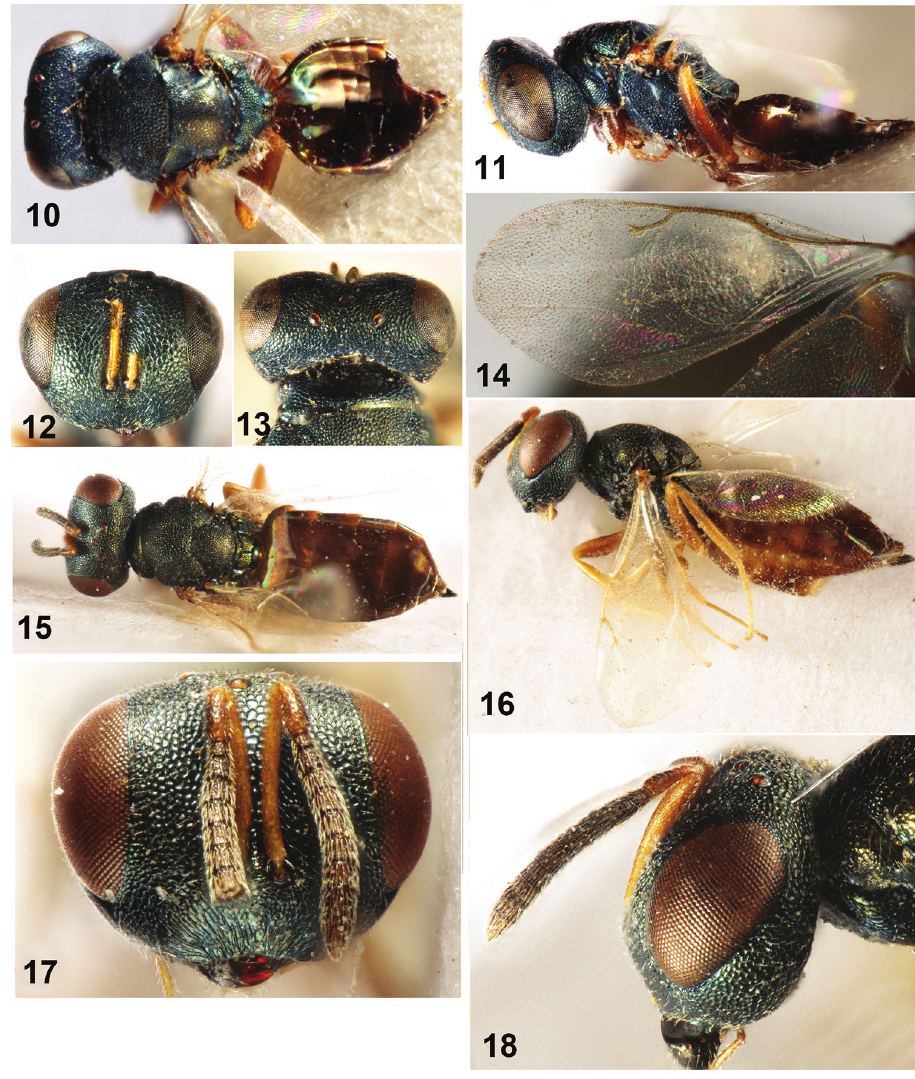
Figures 10–18. 10–14 Dibrachys kunmingica sp. n., female holotype 10 Body in dorsal view 11 Body in lateral view 12 Head in frontal view 13 Head in dorsal view 14 Fore wing 15–18 Dibrachys braco- nidis (Ferrière et Faure, 1925). 15 Body in dorsal view 16 Body in lateral view 17 Head in frontal view 18 Head in lateral